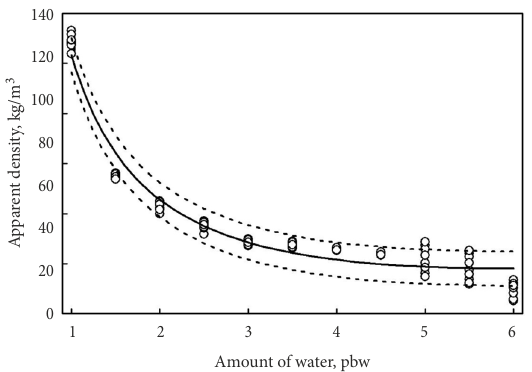
Fig. 2. The dependence of polyurethane foam’s apparent density on the amount of water:  – experimental data;